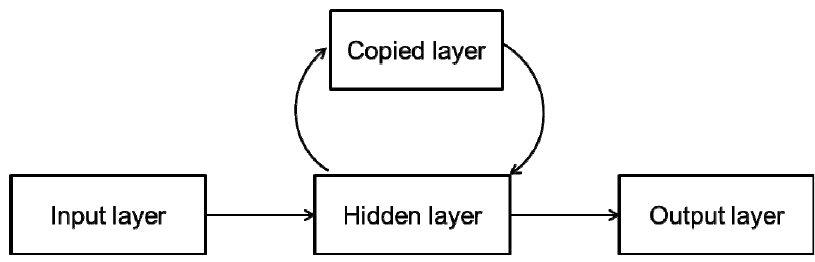
Figure 6. Topology of Elman neural